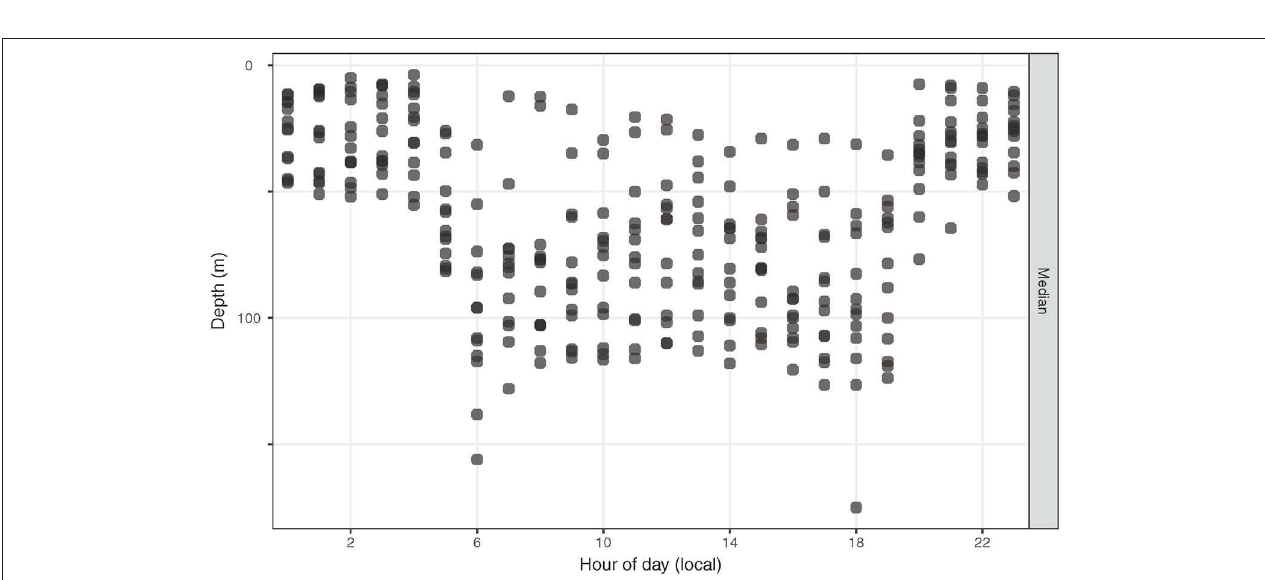
FIGURE 2 | Spatial use around the Main Hawaiian Islands (MHI) by tagged yellowfin tuna. Utilization distribution (UD) is represented in false color. UD values of < 50% signify high use areas. Boundary of MHI Longline Fishing Prohibited Area, purple line. Annotated bathymetric map around the high use areas is included for reference. See methods for map source.